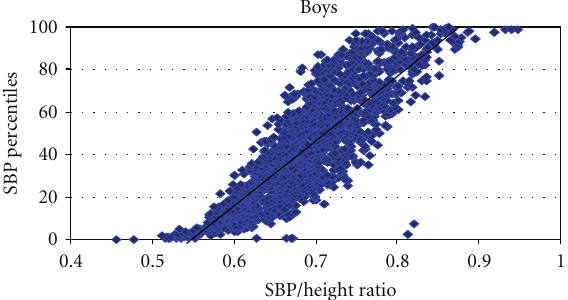
Figure 1: The graph depicts the strong correlation of systolic blood pressure percentiles (SBP Percentiles), on the Y Axis and the systolic blood pressure over height ratio (SBP/height ratio) on the X Axis in